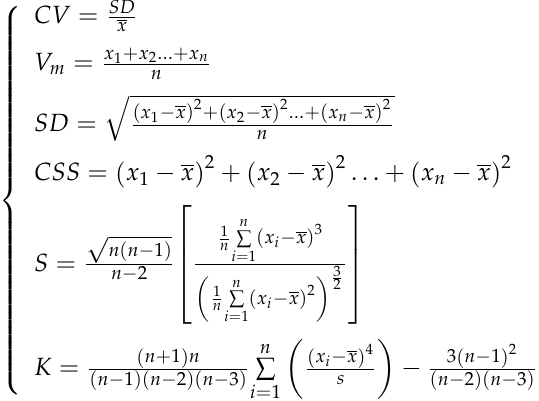
Table 3. Discrete analysis parameters of the output speed of actuators with different friction pairs. Friction Pairs V m SD CSS CV S K ZrO 2 -Si 3 N 4 406.06 307.39 53.29 0.17336 0.08296 − 1.36762 ZrO 2 -GCr 15 265.50 − 0.03711